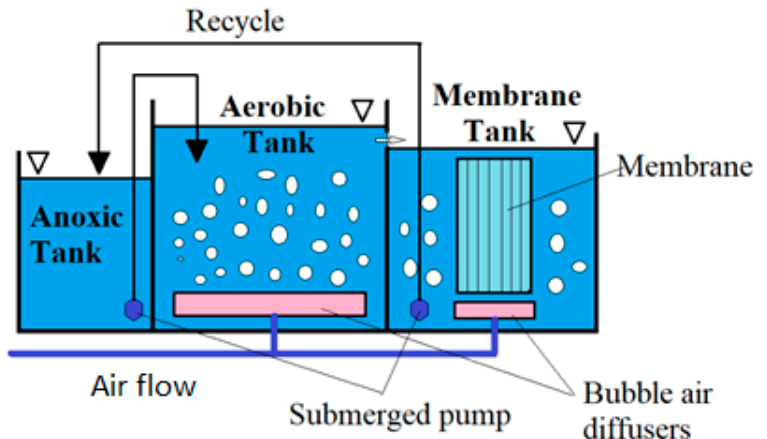
Figure 1. Wastewater treatment in MBRs (membrane biological reactor) (own study).